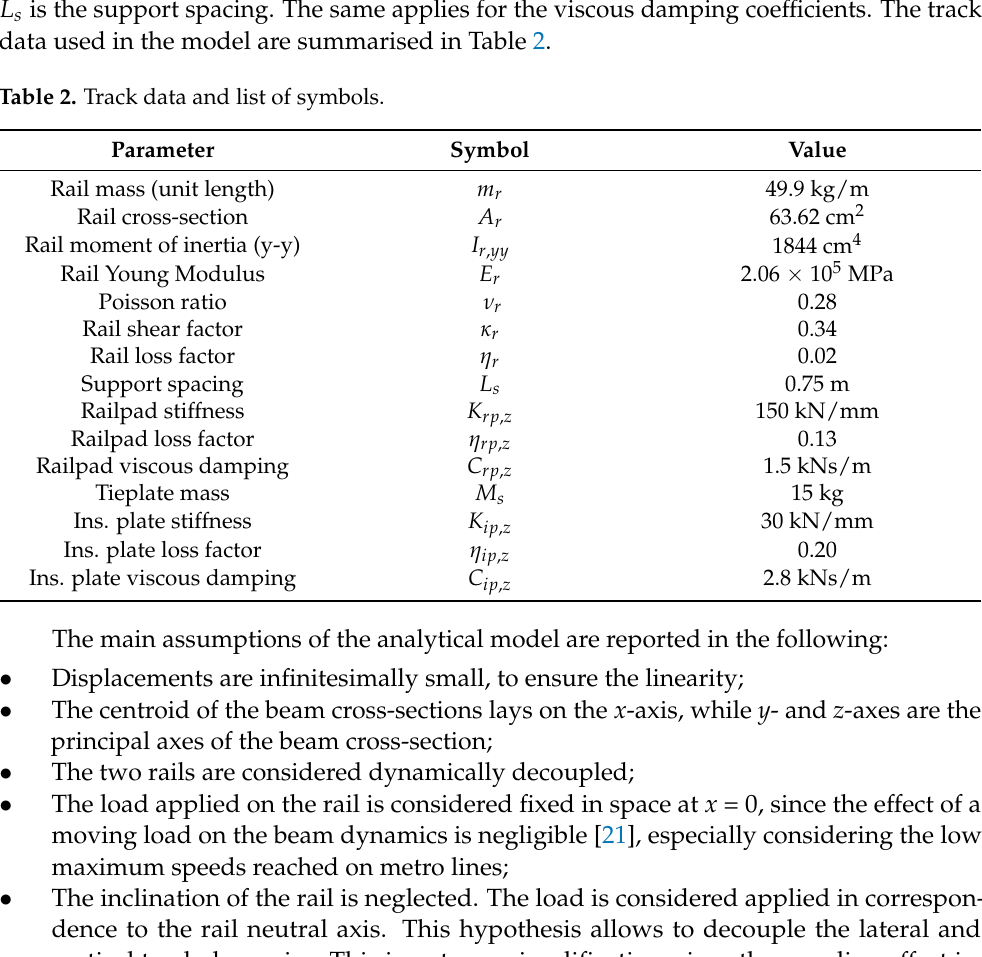
Figure 3b. The rail is modelled as an infinite Timoshenko beam laying on a double-layer elastic support. The first layer is associated with the flexibility of the railpad, while the second represents the elastomeric insulating plate. The metallic tieplate in between is modelled as a rigid mass. The Timoshenko beam model for the rail is chosen to account for the shear deformation, whose effect becomes more relevant as the frequency increases [20].